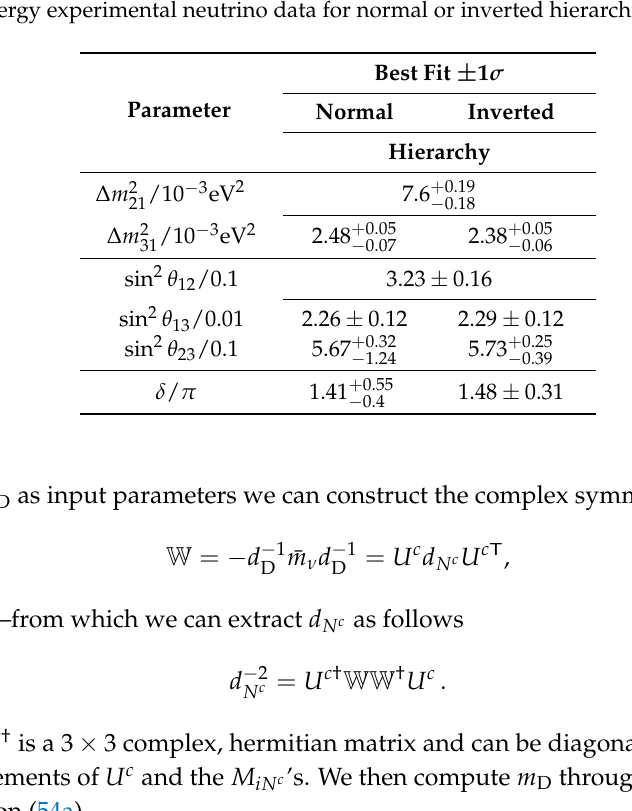
Table 5. Low energy experimental neutrino data for normal or inverted hierarchical neutrino